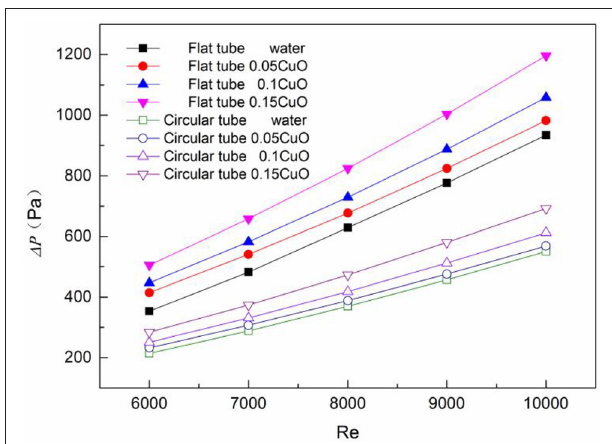
FIGURE 10 | Comparison of pressure drop between flat tube and circular tube flow channel.